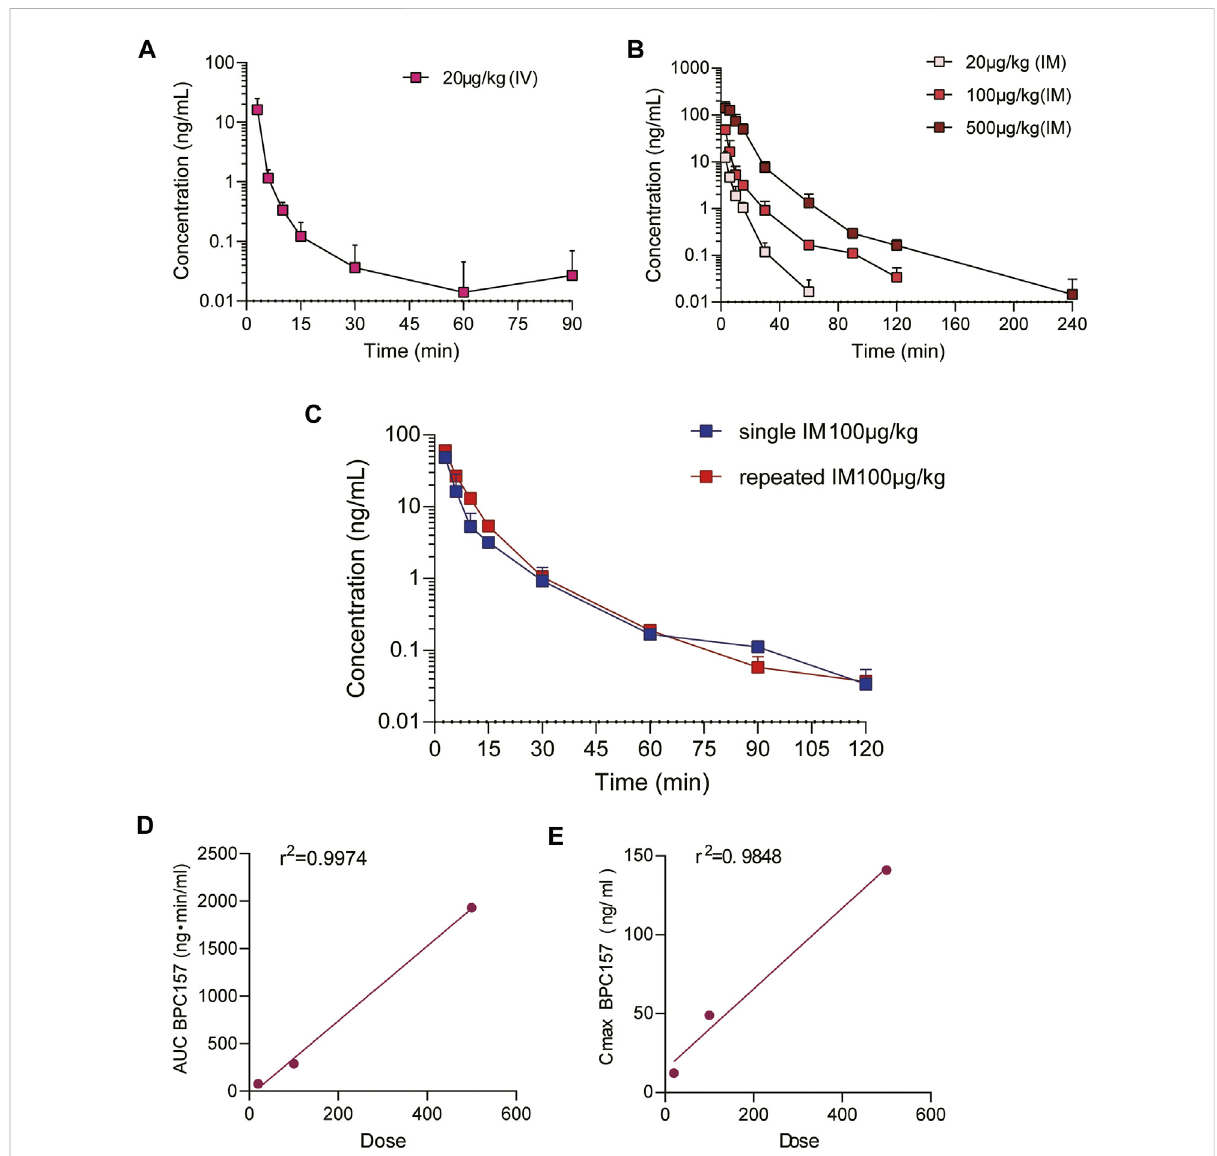
FIGURE 1 Pharmacokinetic studies of BPC157 in rats (mean ± SD, n = 6). (A) Total plasma concentration versus time pro fi les of BPC157 following intravenous administration at a dose of 20 μ g/kg; (B) Total plasma concentration versus time pro fi les of BPC157 following intramuscular administration at the doses of 20, 100, or 500 μ g/kg; (C) Total plasma concentration versus time pro fi les of BPC157 following repeat intramuscular administrationatadoseof100 μ g/kgforsevenconsecutivedays(red)orasingleintramuscularadministrationatadoseof100 μ g/kg(blue). (D) Linear regression between BPC157 AUC and doses evaluated following intramuscular administration of doses 20, 100, or 500 μ g/kg. (E) Linear regression between BPC157 C max and doses evaluated following intramuscular administration of doses 20, 100, or 500 μ g/kg. The goodness of fi t was estimated by the coef fi cient of determination (r 2 ). Data are representative of three independent